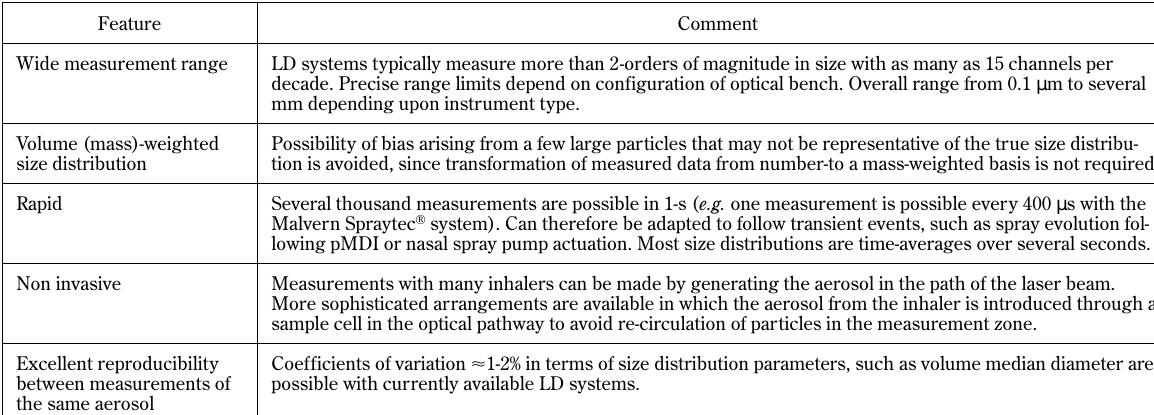
Table 13 Particle size analysis by laser diffractometry (cid:4) Features